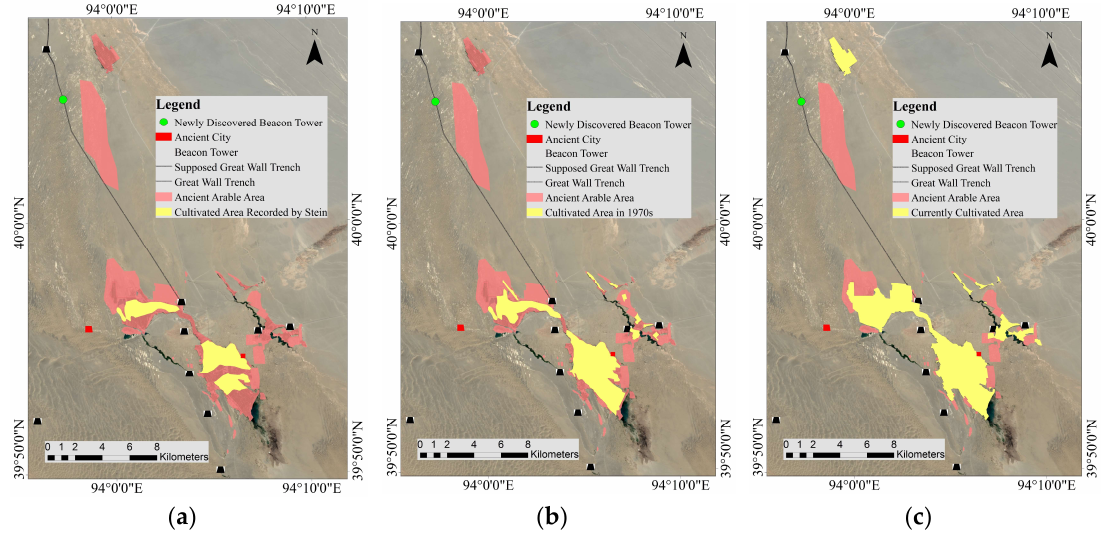
Figure 17. ( a ) Cultivated areas recorded by Stein in the 1910s; ( b ) cultivated areas in the 1970s extracted from Key Hole (KH) satellite images; ( c ) currently cultivated areas extracted from PALSAR-1